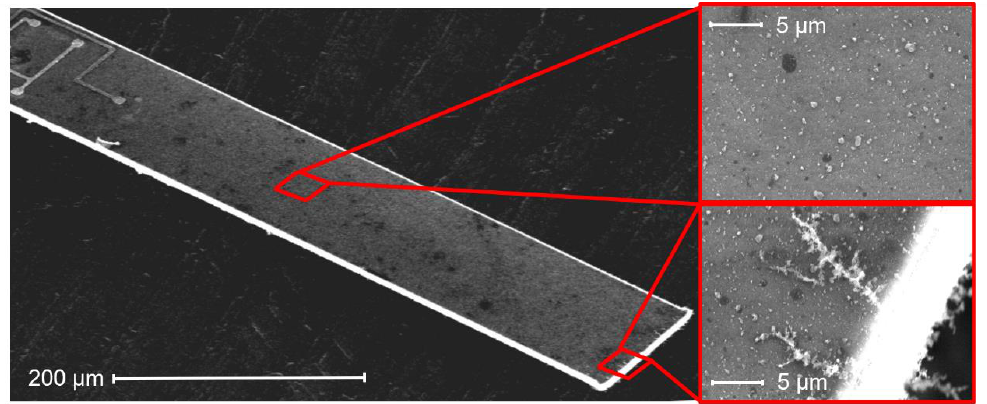
Figure 12. Surface morphology of the sampling area of the EtPCS after carbon-nanoparticle exposure.